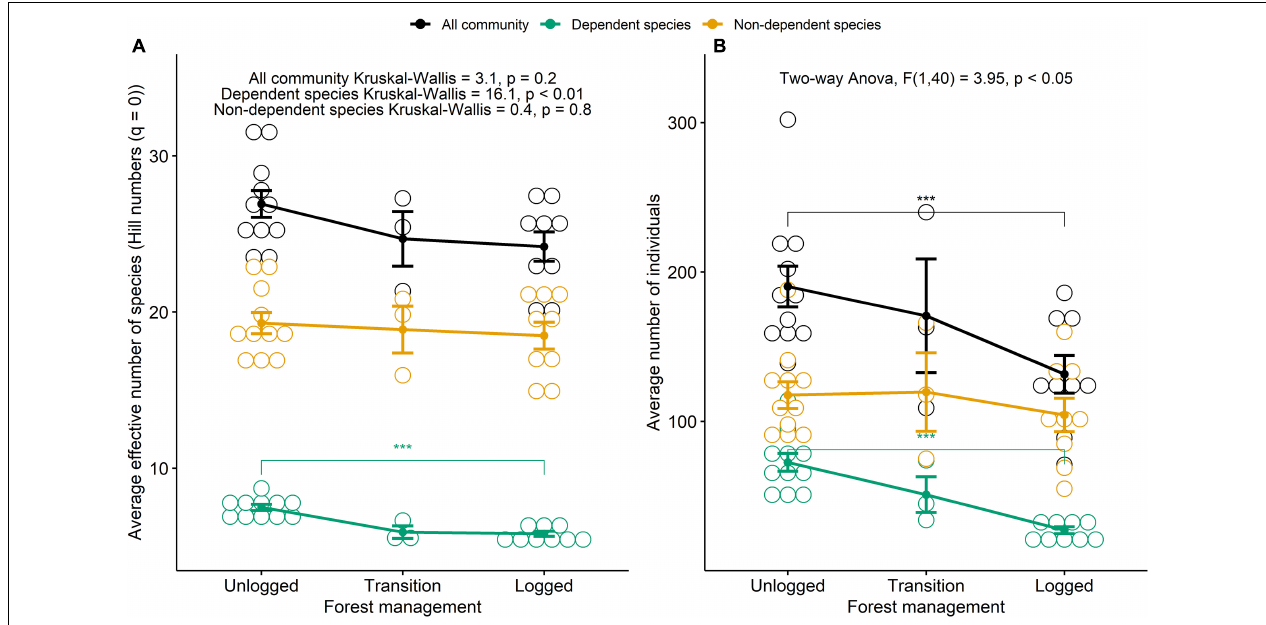
FIGURE 2 | Scatter interval plot with average avian effective number of species (A) and average number of bird individuals (B) recorded in unlogged, transition and logged forest stands at the Fazenda Pau D’Arco, Crato, Ceará, Brazil, for all species (black), forest non-dependent species (yellow), and forest dependent species (dark green). At the top, the used statistical tests. Three Kruskal–Wallis tests for the effective number of species and a two-way ANOVA for the number of individuals. Asterisks show statistical significance according to Dunn’s post hoc test for KW and Tukey’s (HSD) post hoc test for two-way ANOVA.